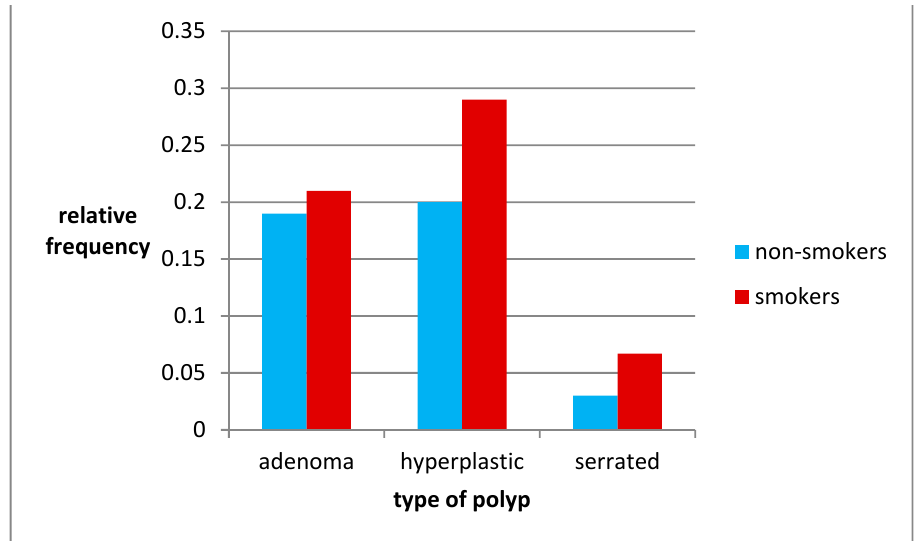
Figure 4. Occurrence of polyp types in smokers and non ‐ smokers.